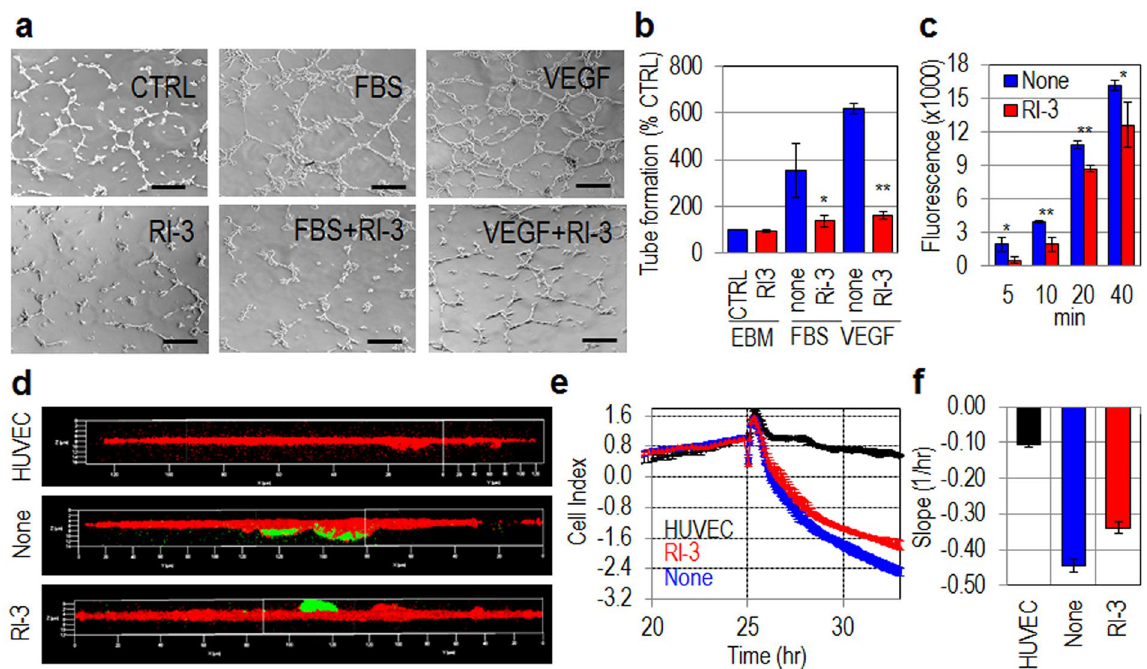
Figure 8. RI-3 prevents in vitro endothelial tube formation, adhesion to endothelium and trans-endothelial migration of sarcoma cells. ( a ) HUVECs were suspended in EBM (CTRL) or EBM with 10% FBS or 40 ng/ mL VEGF 165 , with/without 10 nM RI-3 and seeded on matrigel-coated plates for 6 hr at 37 °C. Representative pictures were taken with an inverted microscope at 100x magnifications. Scale bar: 100 µ m. ( b ) Quantitative analysis of tube formation was calculated as a percentage of tubes formed by cord-like structures exceeding 100 μ m in length, counted in the absence of any angiogenic stimulus and considered as 100% (CTRL). Data represent means ± SD of three independent experiments performed in duplicate. Statistical significance was calculated against None with * P < 0.05 , ** P < 0.0001 . ( c ) HUVEC were seeded onto matrigel and allowed to attach and to growth for 24 hr prior to seeding GFP-Sarc cells suspended in complete endothelial medium plus/ minus diluents (None), or 10 nM RI-3 at 37 °C, 5% CO 2 . At the indicated times, cell associated fluorescence was assessed by a fluorescence plate reader. Data represent means ± SD of three independent experiments performed in duplicate. Statistical significance was calculated against None with * P < 0.05 , ** P < 0.0001 . ( d ) After 2 hr, cells were stained with rhodamine-phalloidin and GFP-Sarc cells visualized on multiple z-series collected at 0.20 µ m intervals using a confocal microscope. Representative images recorded in 3D projection. Original magnifications: 400x. ( e ) Trans-endothelial migration of Sarc cells. HUVECs (1 × 10 4 cells/well) suspended in growth medium, were allowed to grow for 25 hr until they form a confluent monolayer, prior to seeding Sarc cells (1 × 10 4 cells/well) in growth medium plus/minus 10 nM RI-3. Data represent mean ± SD from a quadruplicate experiment. Slopes ( f ) represent the change rate of cell index values generated in a 25–35 hr time